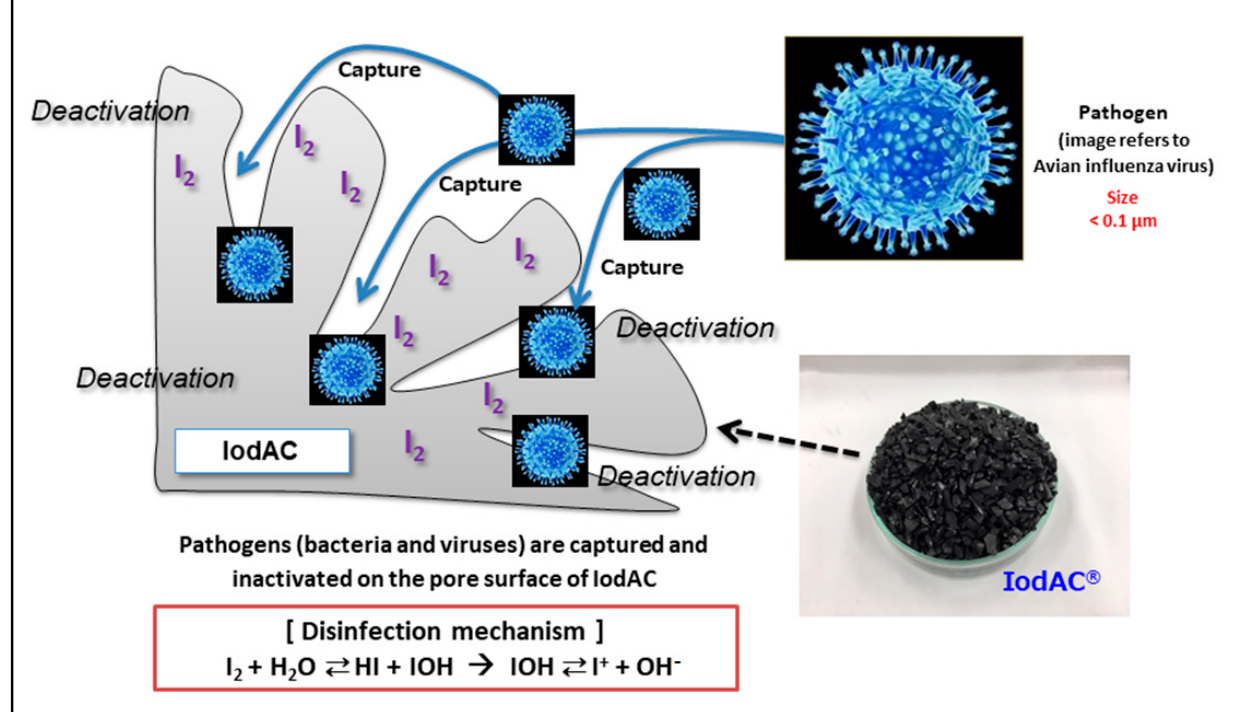
Figure 3. Explanation of IodAC disinfecting action.